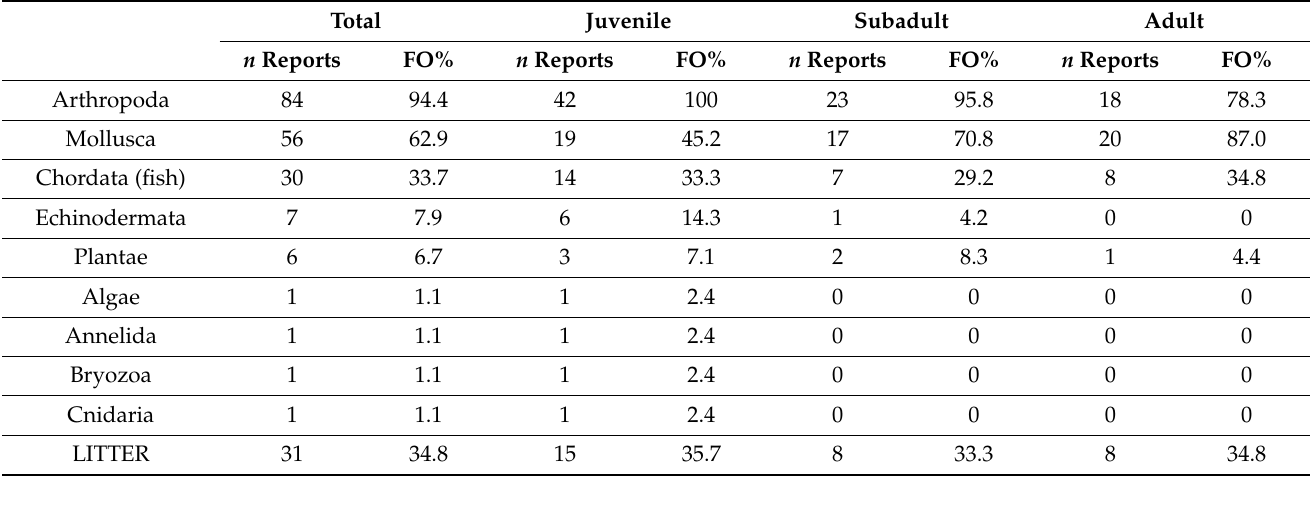
Table 1. Frequency of occurrence of food and litter ingestion in loggerhead sea turtles from the Adriatic Sea: number of reports and FO% per phylum in the groups of juveniles ( n = 42), subadults ( n = 24), and adults ( n = 23).